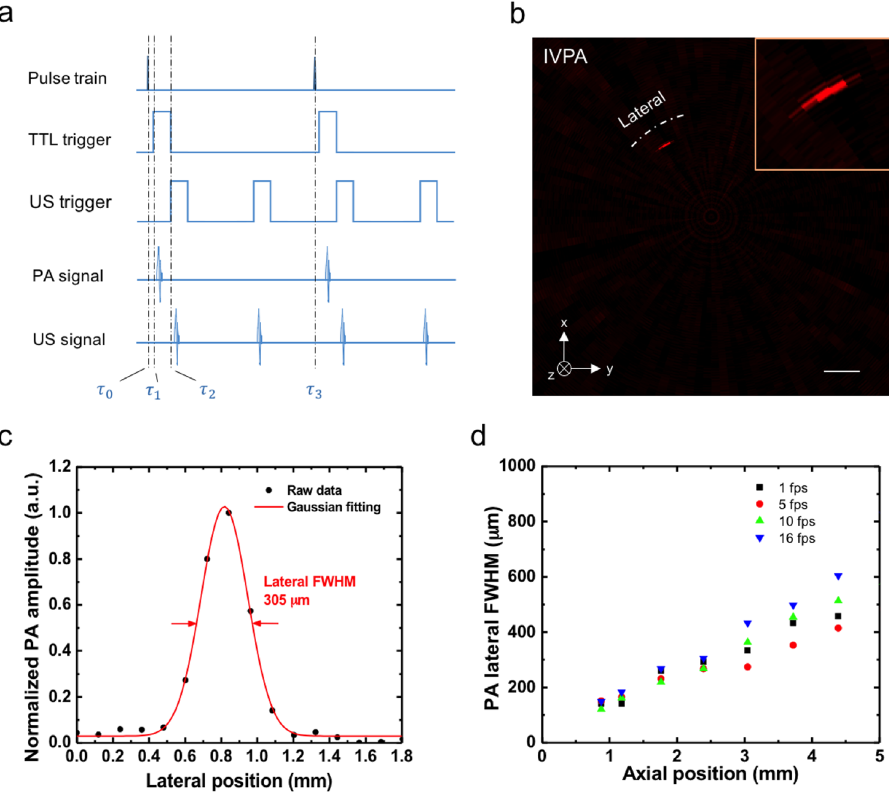
Figure 4. Differentiated A-line strategy and A-line number verification for IVPA-US imaging at 16 fps. ( a ) Timing diagram of IVPA-US imaging. τ , 0 µ s; τ , 0.126 µ s; τ , 8.126 µ s; τ , 258.126 µ s. TTL trigger refers to the 0 1 2 3 trigger signal from laser. ( b ) Cross-sectional IVPA image of a single carbon fiber with diameter of 30 µ m for spatial resolution characterization. The image shown was reconstructed by raw imaging data without A-line interpolation. Inset shows the zoom-in IVPA image. Scale bar: 1 mm. ( c ) Lateral plot of the carbon fiber in IVPA image at an axial position of 2.38 mm. The lateral resolution of 305 µ m is estimated by the full with at half maximum (FWHM) of Gaussian fitted curve. ( d ) IVPA lateral resolution at different axial position at imaging speeds of 1, 5, 10, and 16